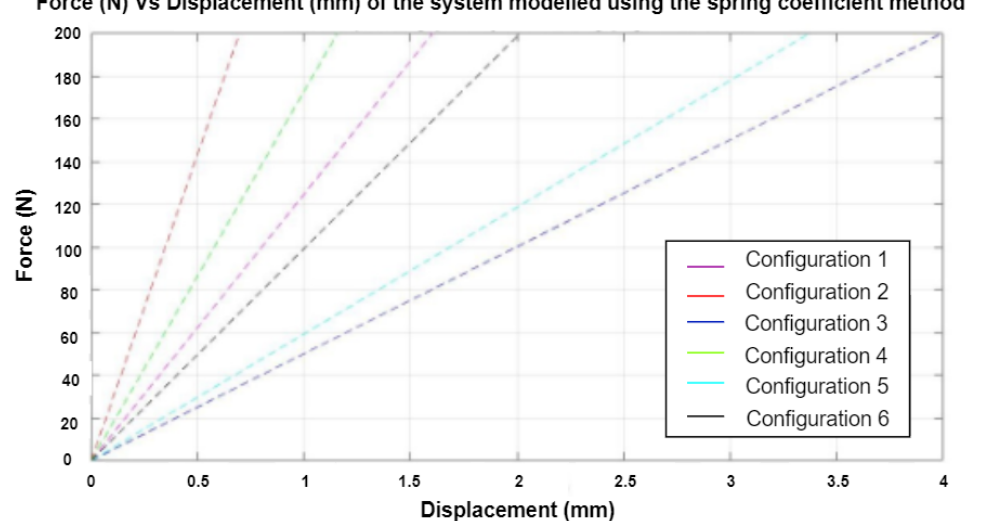
Figure 18. Force displacement graph generated using calculated spring coefficients. Configuration 1—Magenta, Configuration 2—Red, Configuration 3—Blue, Configuration 4—Green, Configuration 5—Cyan, Configuration